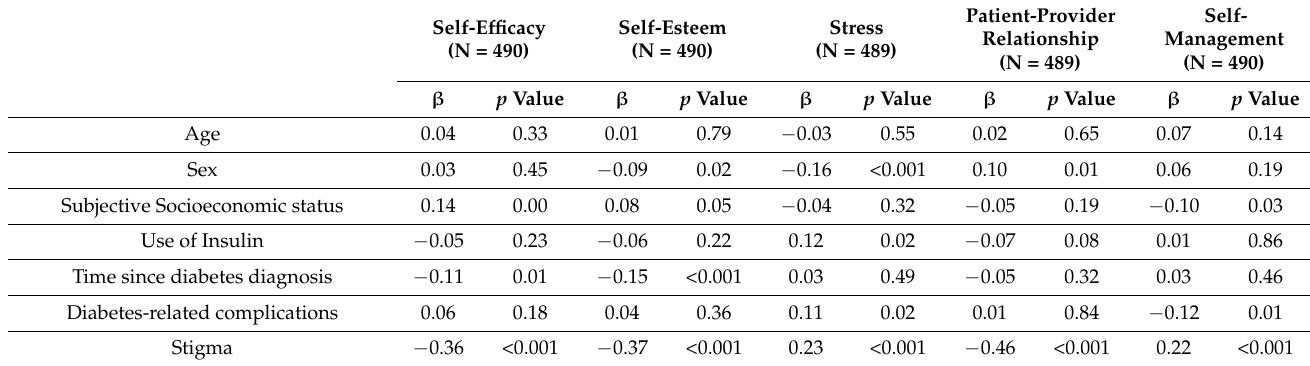
Table 5. Regression analysis for the relationship between stigma surrounding diabetes, sociodemographic, and clinical